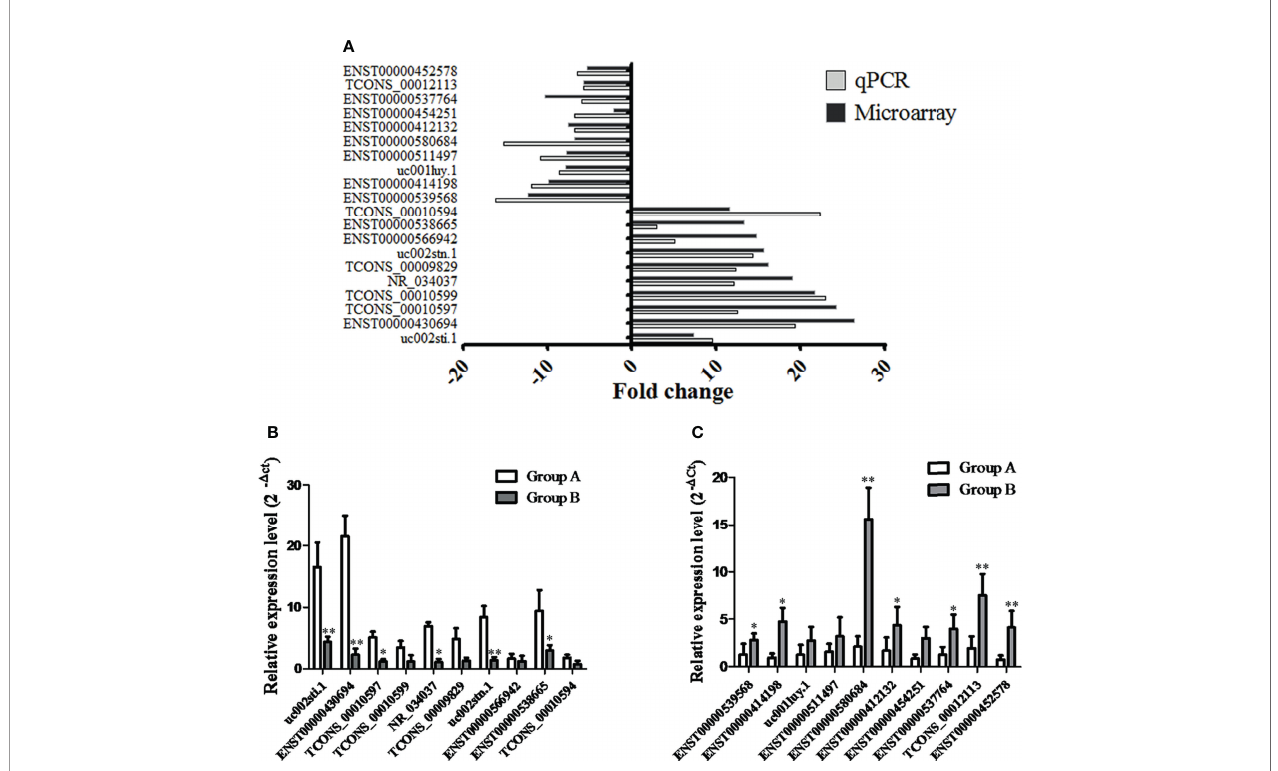
FIGURE 3 | The differential expression of 20 lncRNAs observed by microarray was validated by qRT-PCR. Fold changes were calculated using the 2- D Ct method. The heights of the columns in the chart represent the median fold changes in expression of each of the validated lncRNAs across the patients (A) . The relative expression of up-regulated lncRNAs and down-regulated lncRNAs are presented in (B, C) , respectively. Data are presented as the mean ± SD. GAPDH was used as a control. * indicates P < 0.05. ** indicates P < 0.01. Group A indicates PTC/HT (+), Group B indicates PTC/HT (-).